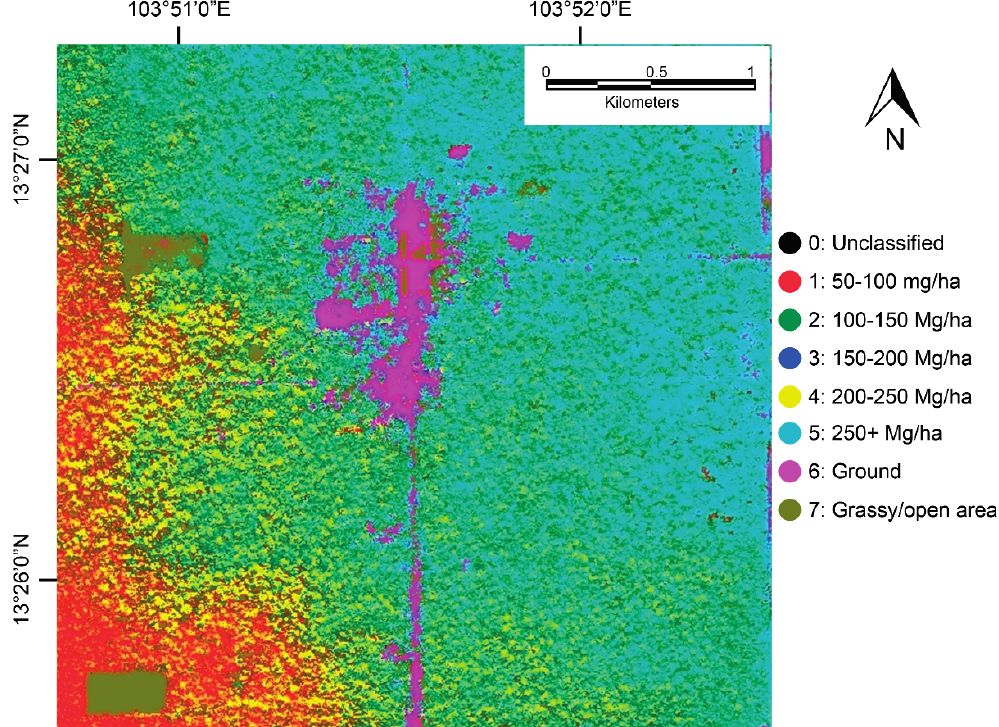
Figure 10. Spatial distribution of above-ground biomass in Angkor Thom, based on a best-fit SVR + vertical canopy + horizontal canopy + GLCM